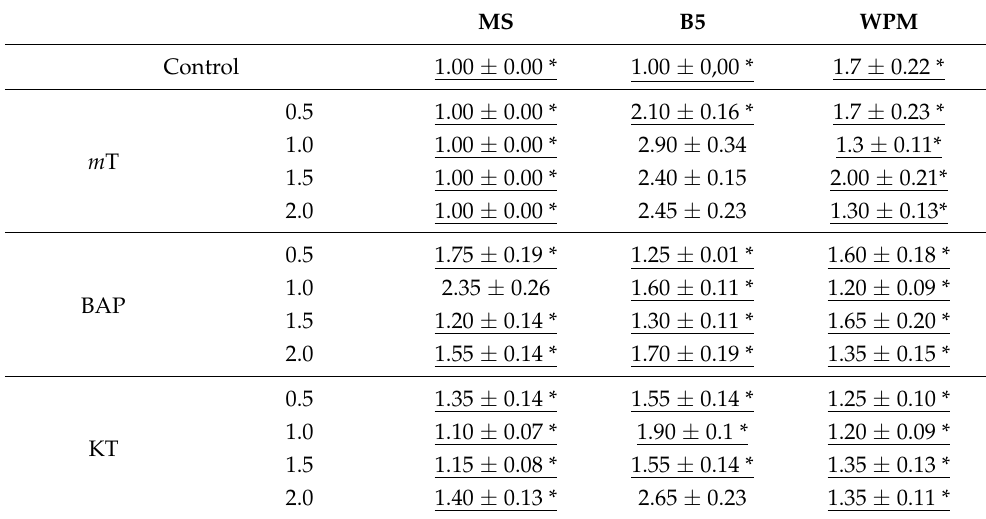
Table 2. Average values of H. grandiflorum multiplication coefficient on different nutrient media.